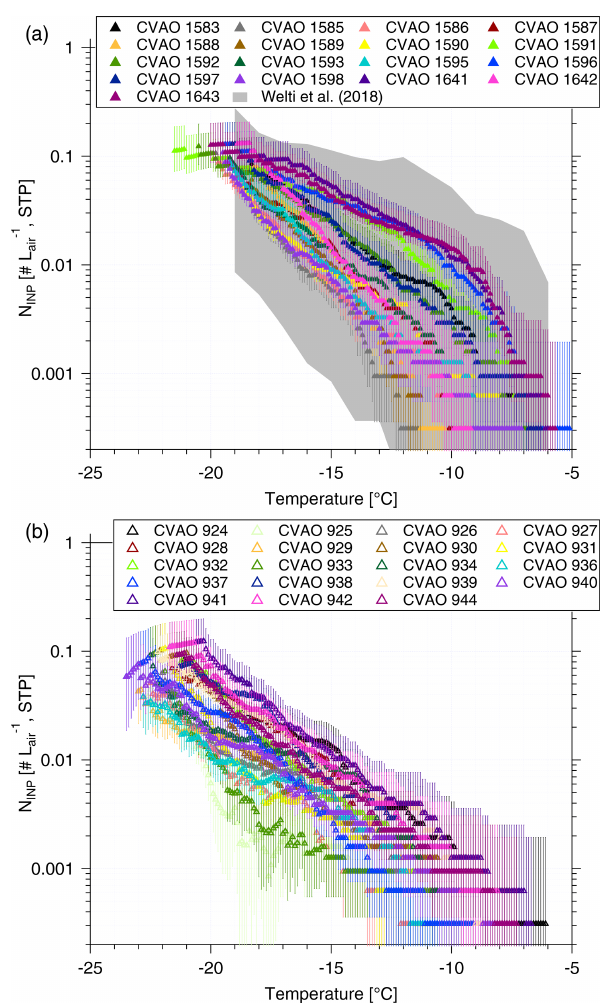
Figure 3. N INP as a function of temperature from CVAO PM 10 fil- ters (a) and CVAO PM 1 filters (b) . The field measurement of N INP in PM 10 by Welti et al. (2018) is shown by gray shading in panel (a) . Error bars show the 95% confidence interval.